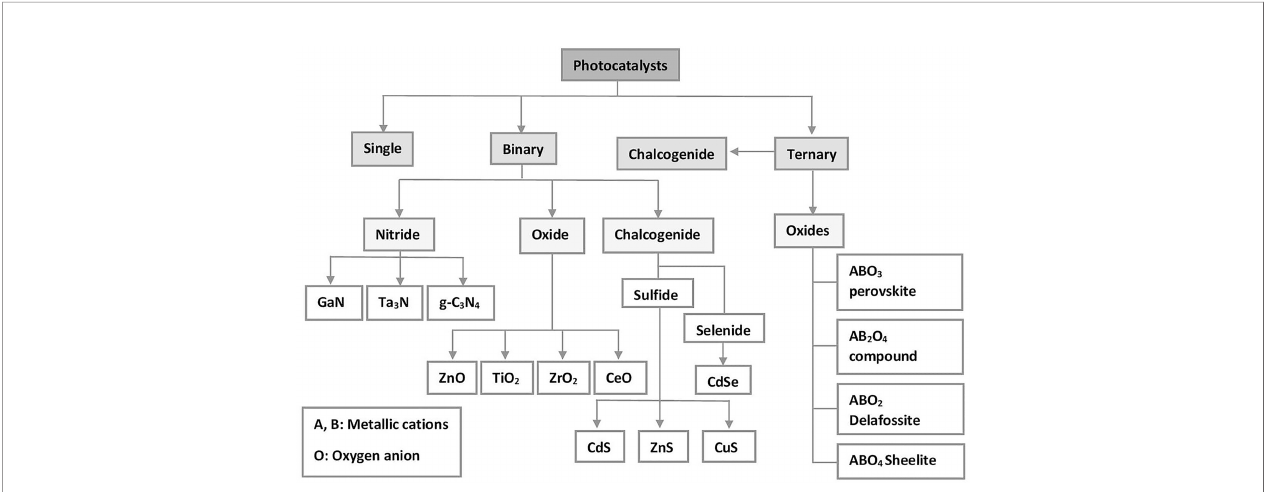
FIGURE 4 | Flow chart of some binary and ternary semiconductor photocatalysts.